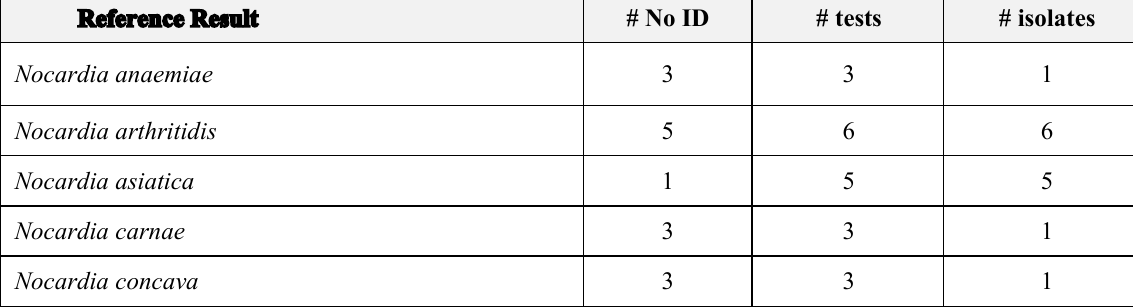
TABLE 6: Nocardia species tested; VITEK MS result ‘No